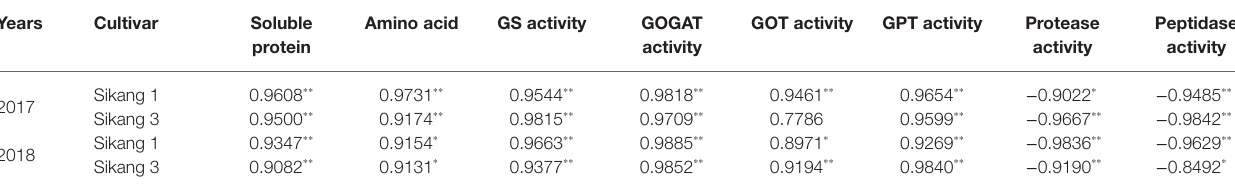
TABLE 1 | Analysis of relation between insecticidal protein and enzymatic activities in Bt